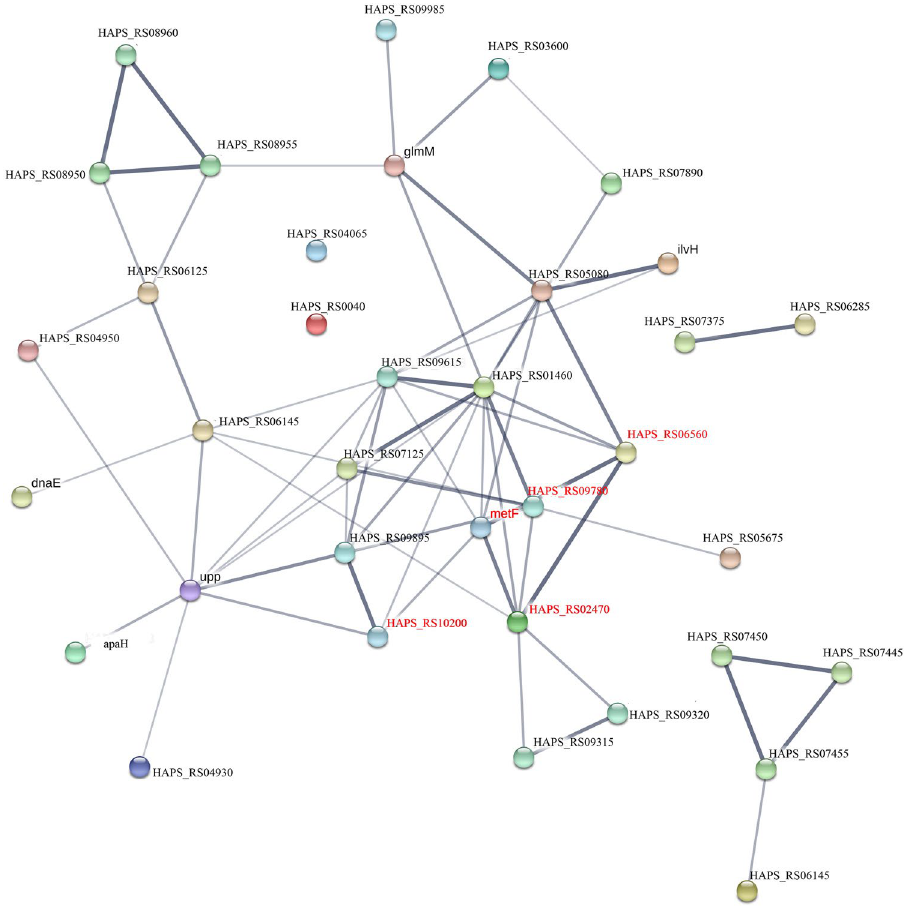
Figure 5. STRING analysis of the relationship between main 40 DE genes in metabolic pathways. The downregulated genes were marked with red, and the others were upregulated